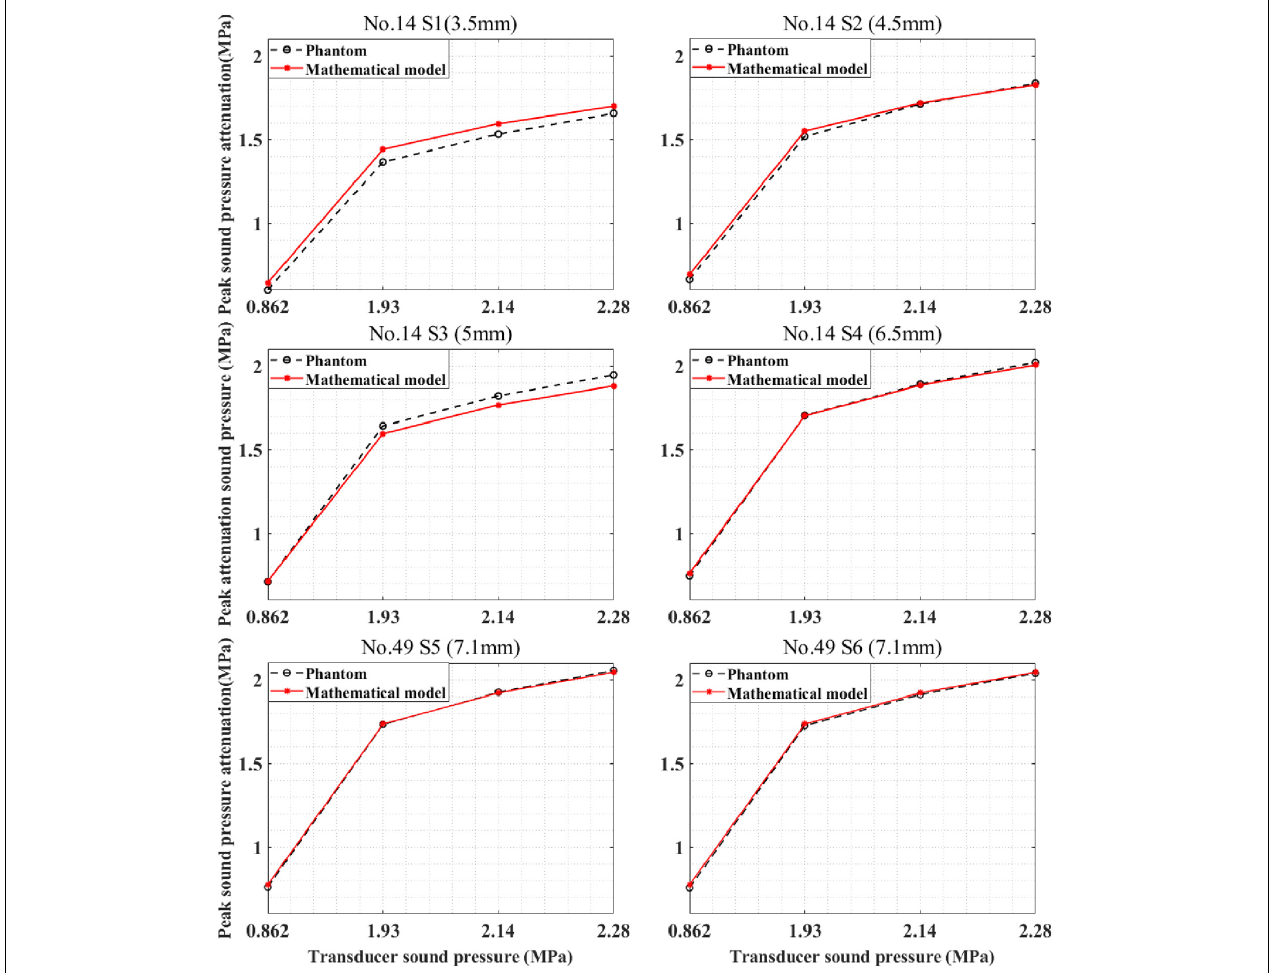
FIGURE 11 | Peak sound pressure attenuation results of model prediction and phantom experiment for different skulls. S1–S4 are located at different positions of skull No. 14, and S5, S6 are located on skull No.